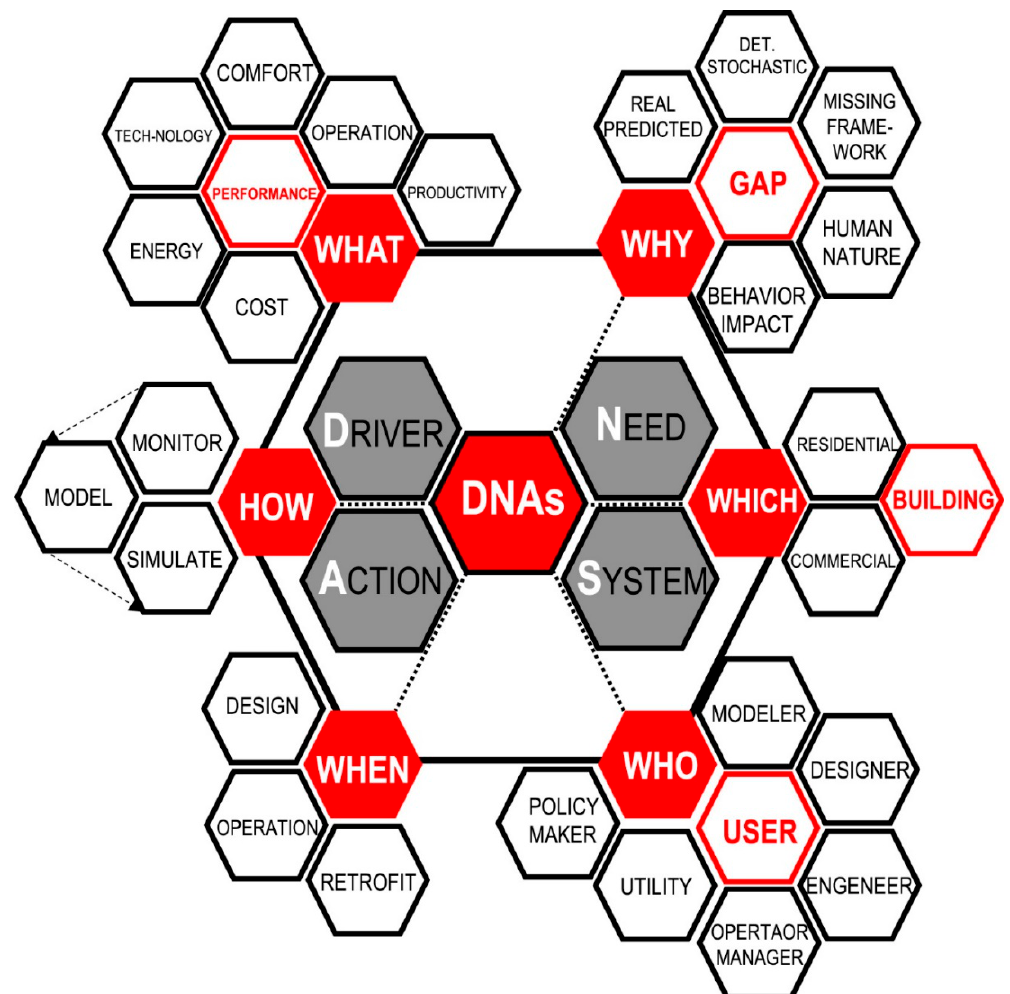
Figure 16. DNAs Framework Applications [112] (Reprinted from Elsevier Building and Environment, Volume 92, Tianzhen Hong, Simona D’Oca, William J.N. Turner, Sarah C. Taylor-Lange, An ontology to represent energy-related occupant behavior in buildings. Part I: Introduction to the DNAs framework, Pages No. 764–777, Copyright (2015), with permission from Elsevier [OR APPLICABLESOCIETY COPYRIGHT OWNER]).